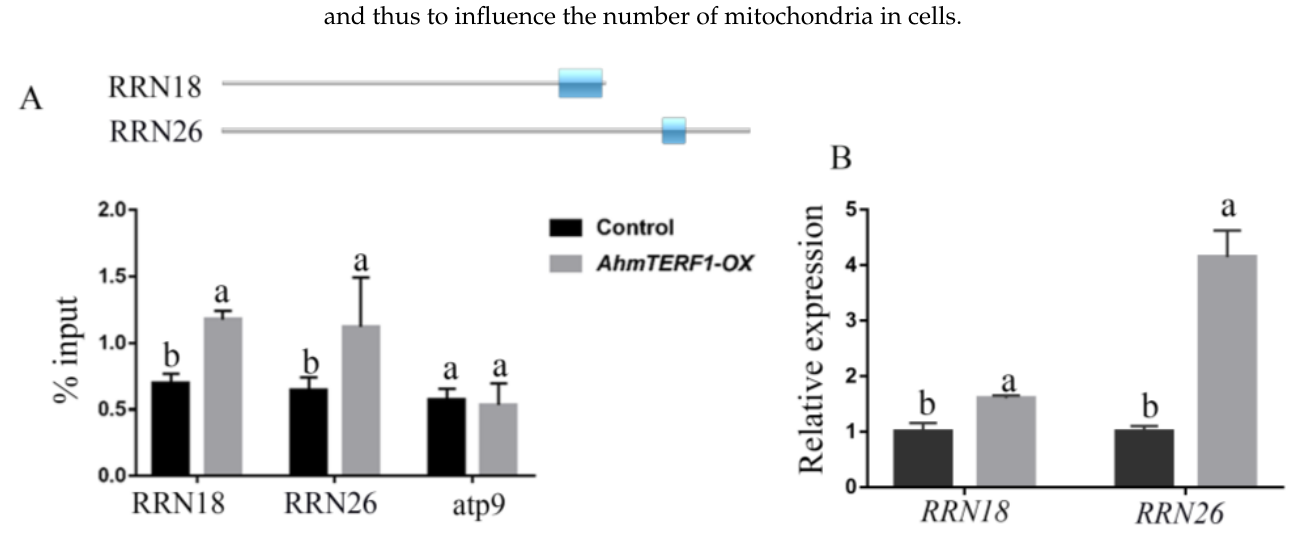
Figure 7. AhmTERF1 binds specifically to and regulates its target rRNA genes, RRN18 and RRN26. ( A ): Enrichment of AhmTERF1 binding to RRN18 and RRN26 DNA sequences shown by ChIP- qPCR, with atp9 as negative control. Cox is used as an internal reference. The upper figure repre- sents gene sequences. Blue rectangles represent the enrichment region. ( B ): RRN18 and RRN26 ex- pression in Control and AhmTERF1-OX hairy roots. Lower case letters (a, b) indicate significantly different groups ( p < 0.05).